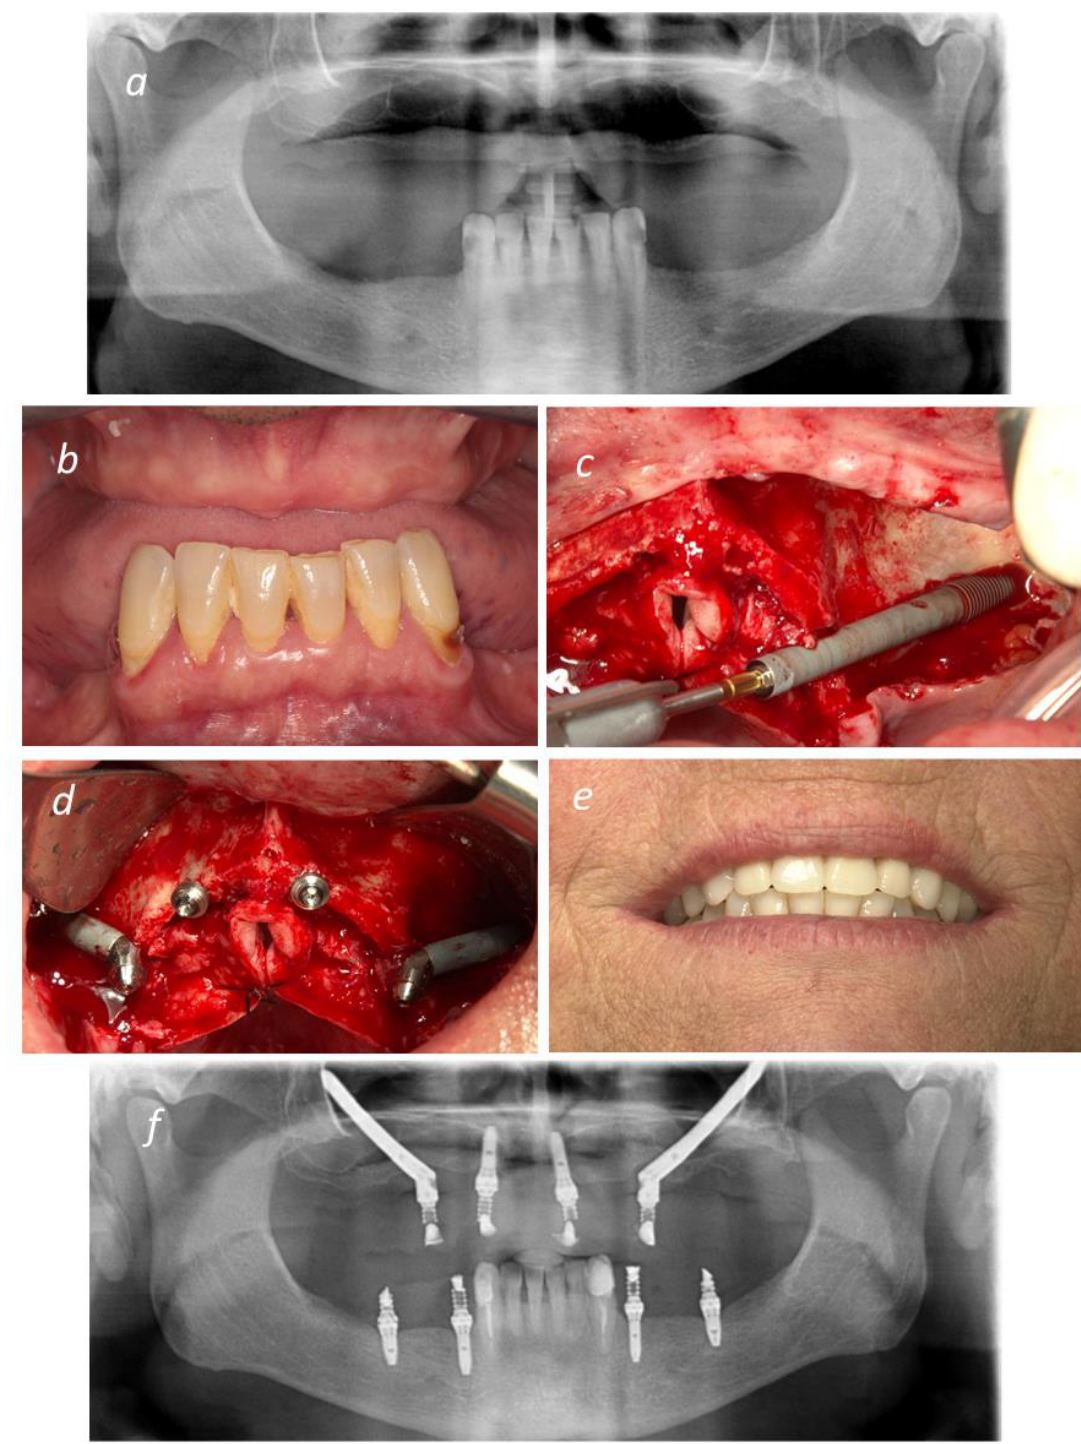
Figure 2. Representative figures of an All-on-4 Hybrid rehabilitation: ( a ) Pre-operative Orthopantomography; ( b ) Pre- operative intra-oral photograph in frontal view; ( c ) Insertion of NobelZygoma 0 ◦ implant through the Extramaxillary surgical technique; ( d ) Two NobelZygoma 0 ◦ implants inserted bilaterally in the posterior region with 45 ◦ Multi-unit abutments and two anterior NobelSpeedy Groovy implants with straight Multiunit abutments (All-on-4 Hybrid); ( e ) Immediate Provisional prosthesis loaded on the day of surgery; ( f ) Post-operative